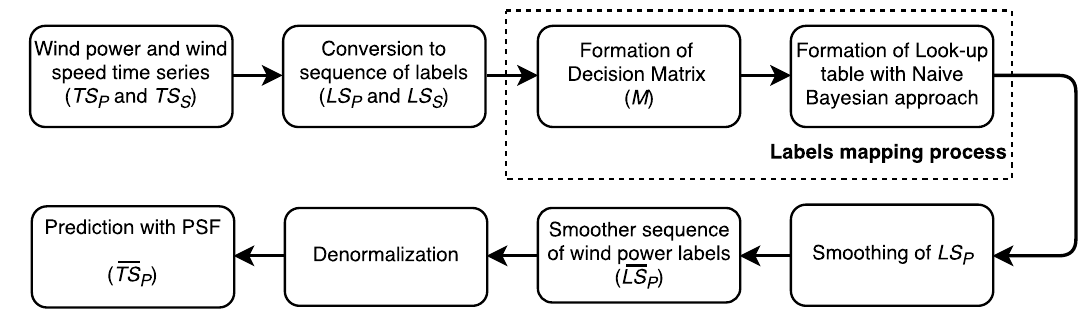
Figure 3. Block diagram of the proposed